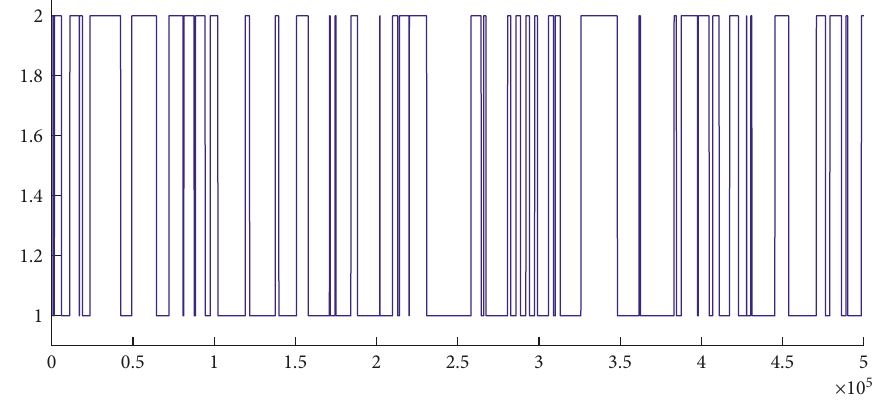
Figure 1: Trajectories of Markov chain r ( t ) .